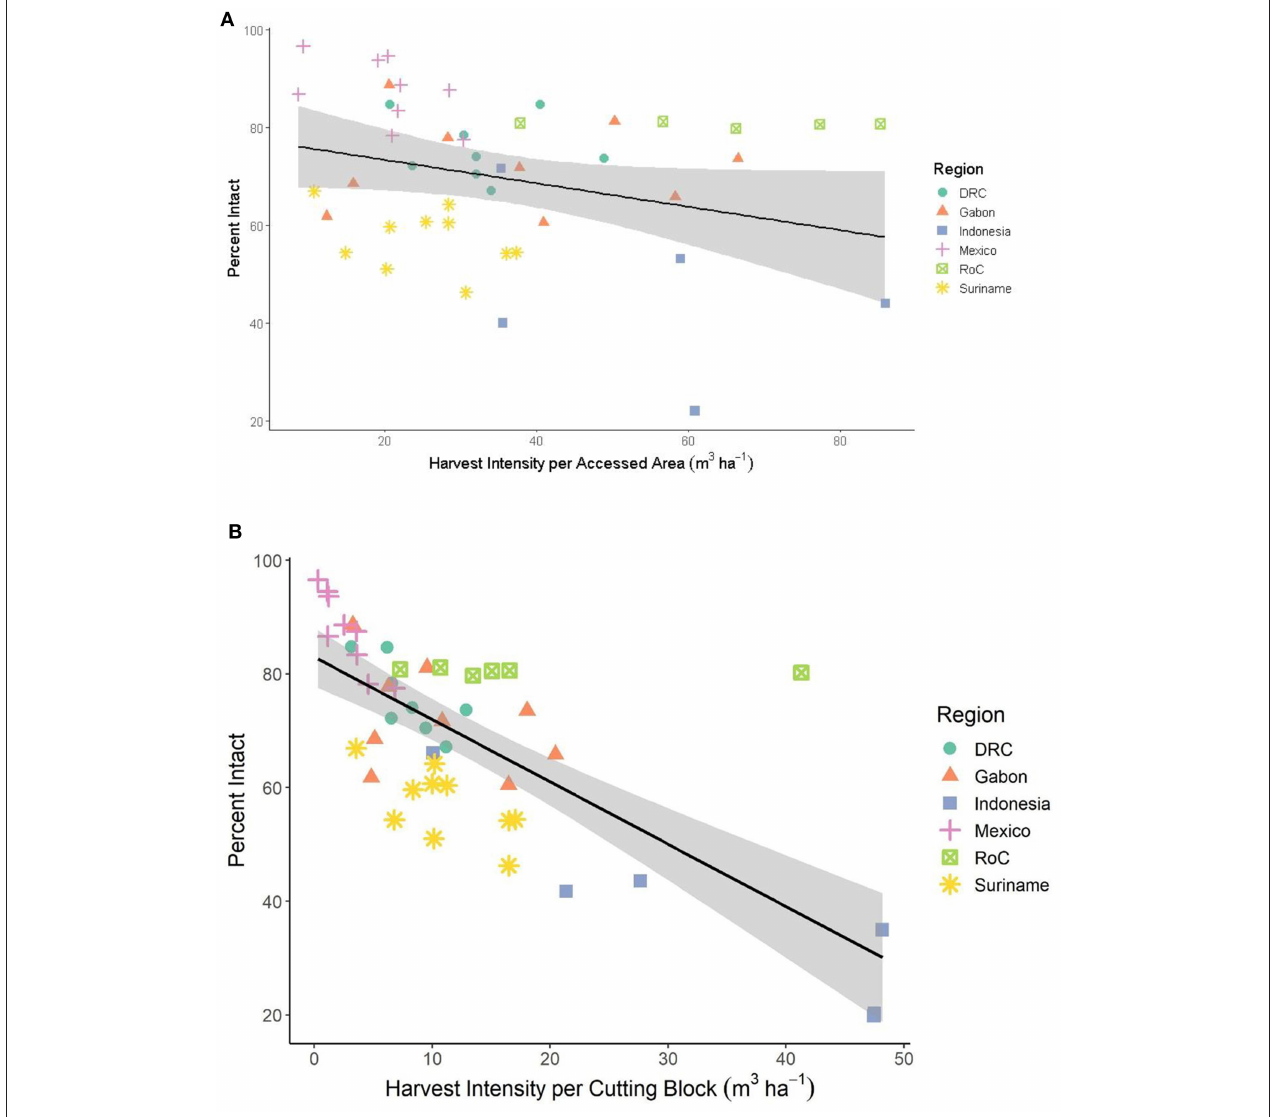
FIGURE 3 | The extents of intact forest (%) in selectively logged forests as a function of harvest intensities (m 3 ha − 1 ) in accessed areas (A) and across entire logging (cutting) blocks (B)